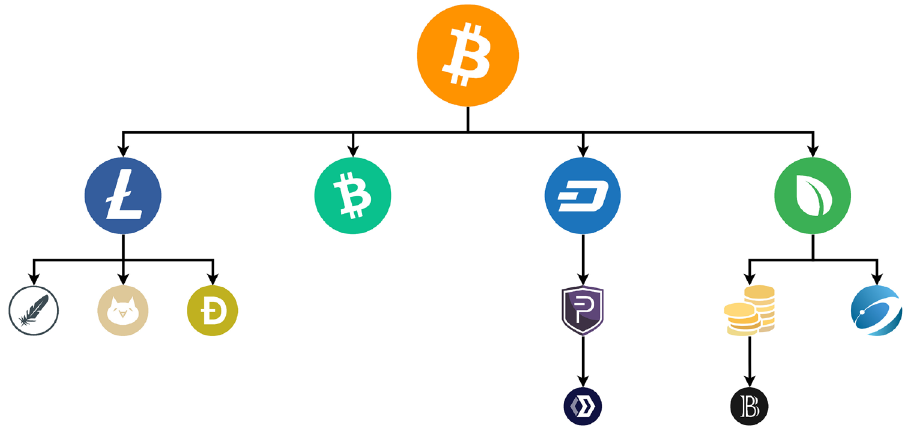
Figure 3. Forks of Bitcoin. Schematic representation of Bitcoin forking tree. Each time a new cryptocurrency is created, its code (software fork) or its blockchain (hard fork) can be used as a starting point for the creation of new coins and blockchains. For instance Litecoin has been created by minor modifications of Bitcoin code and in its turn Litecoin source code has been used to develop many other coins such as the well known Dogecoin. The creation of new cryptocurrencies can be described in terms of an adjacent possible process. Figure created with www. diagr ams. net.